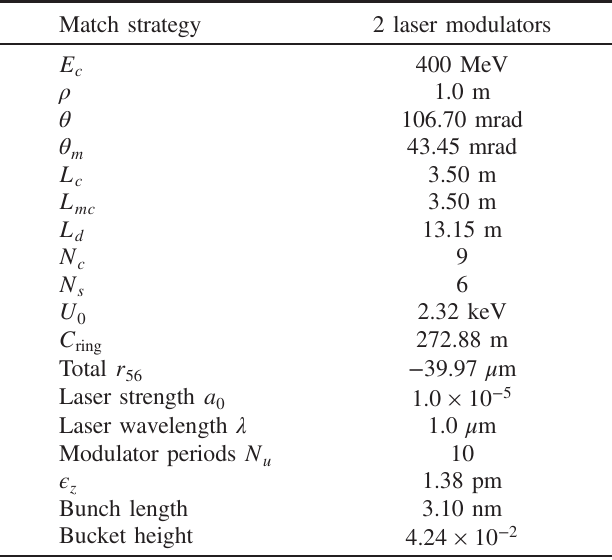
TABLE II. Parameters of a sample longitudinal-emittance- minimized ring.